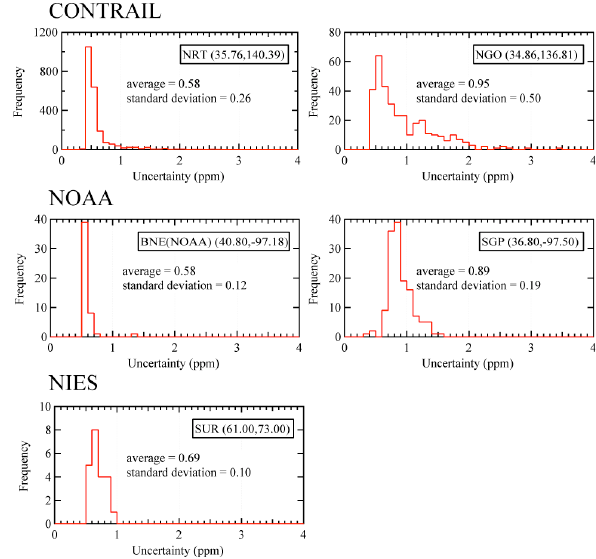
Fig. 5. Frequency distributions of the estimated uncertainties at five Figure 5. Frequency distributions of the estimated uncertainties at five sites. The size of each 2 sites. The size of each frequency class is frequency class is 0.2 ppm. 3